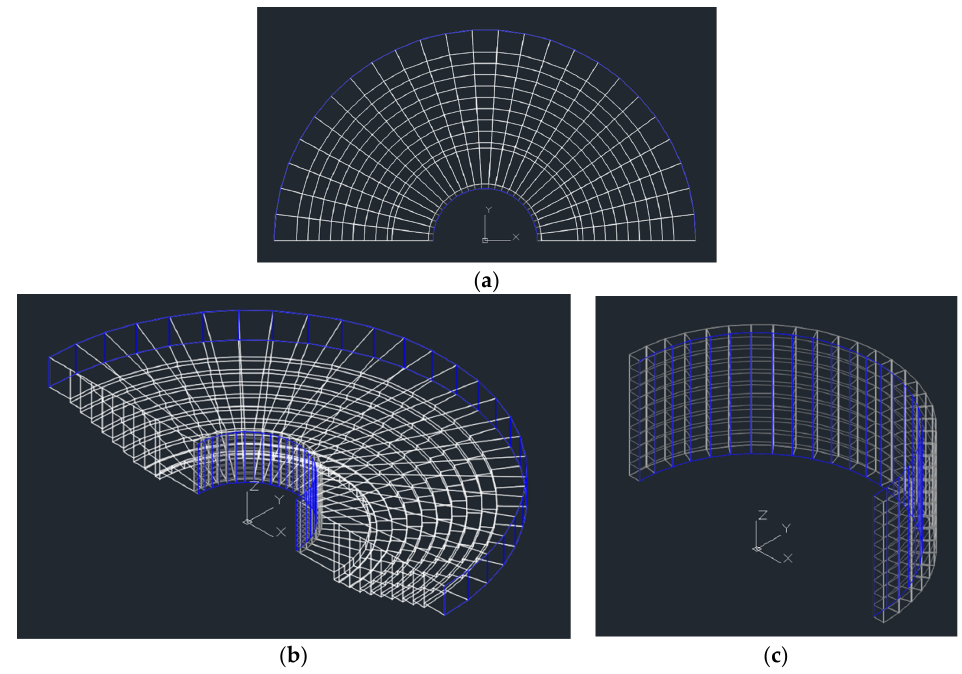
Figure 9. Virtual auditorium developed in Case A. ( a ) Top view of the auditorium and the semi- circular DSF, ( b ) tri-dimensional southeast view of the auditorium and the semi-circular DSF, and ( c ) tri-dimensional southeast view of the semi-circular DSF.